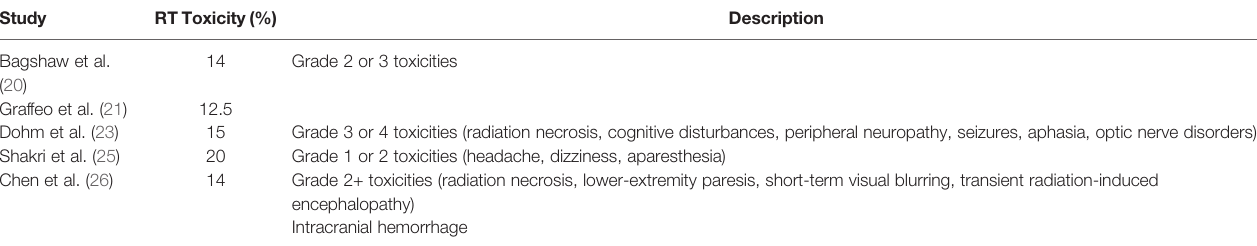
TABLE 2 | Toxicity of postoperative adjuvant